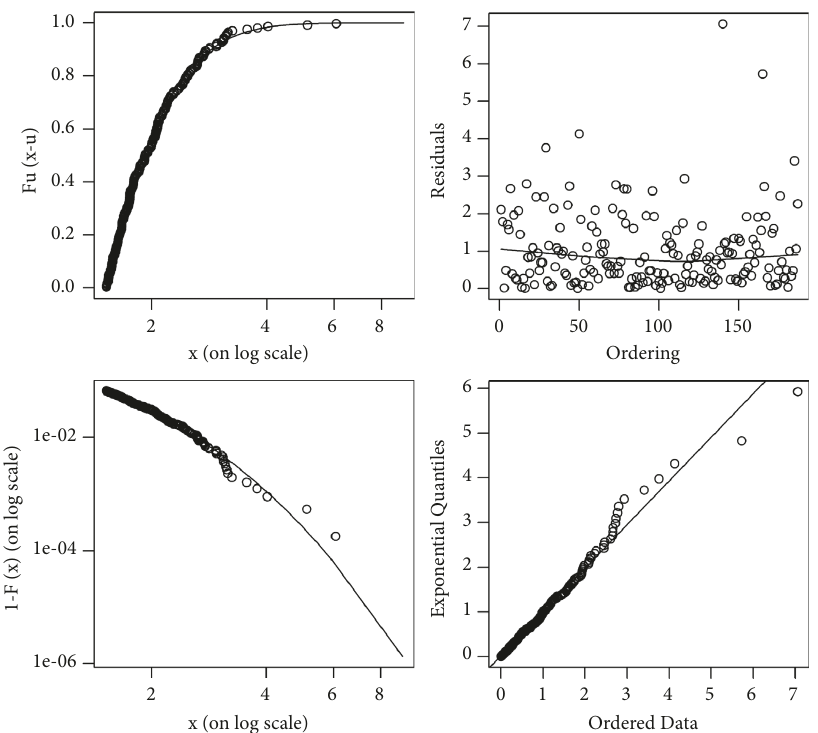
Figure 8: Palm oil positive returns GPD fitted diagnostic